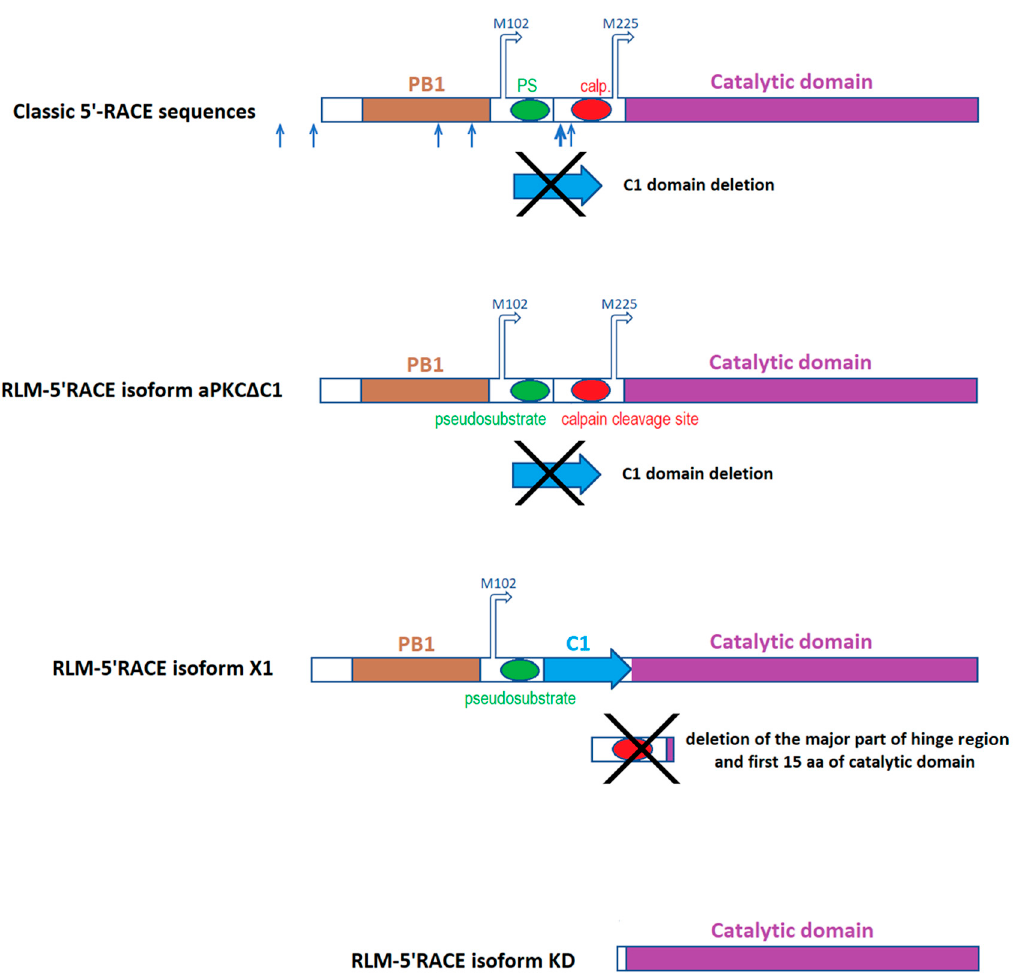
Figure 3. Schematic representations of putative snail aPKC isoforms based on 5’-RACE results. Arrows above the molecule represent possible translation starts. Numbers of amino acids in 5’-RACE isoforms are given based on corresponding snail contig. Arrows below the molecule in classic 5’-RACE sequences represent starts of fragments with different lengths (the largest arrow represents the common start of 2 fragments). PS–pseudosubstrate, calp.–calpain cleavage site.